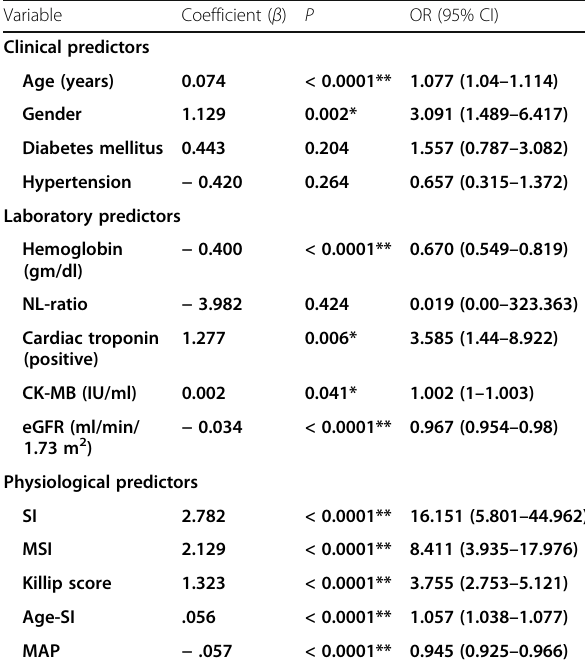
Table 5 Univariate logistic regression in prediction of mortality in the studied group Variable Clinical predictors